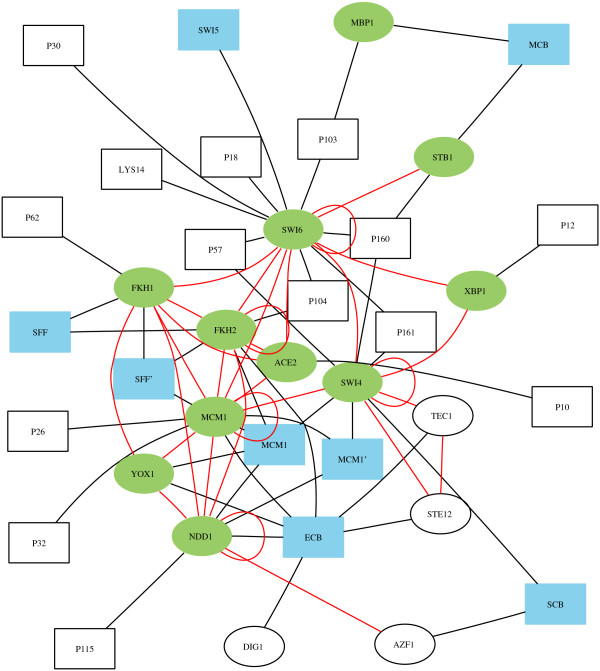
Examples of cell cycle control. Transcription factors (ellipses) are linked by (red) edges if they appear in the same combination at p-value threshold 0.000195. The corresponding sequence motifs (rectangles) occurring in cis-regulatory descriptors with these transcription factors are also shown, and black edges indicate with which factors they belong. Green indicate known phase-specific factors, while blue indicate known phase-specific motifs. Motifs named P# are putative motifs (see Additional file 4). Thus, for instance, one sees that the forkhead proteins FKH1 and FKH2 bind to genes that have the SFF and SFF' motifs and tend to bind simultaneously.